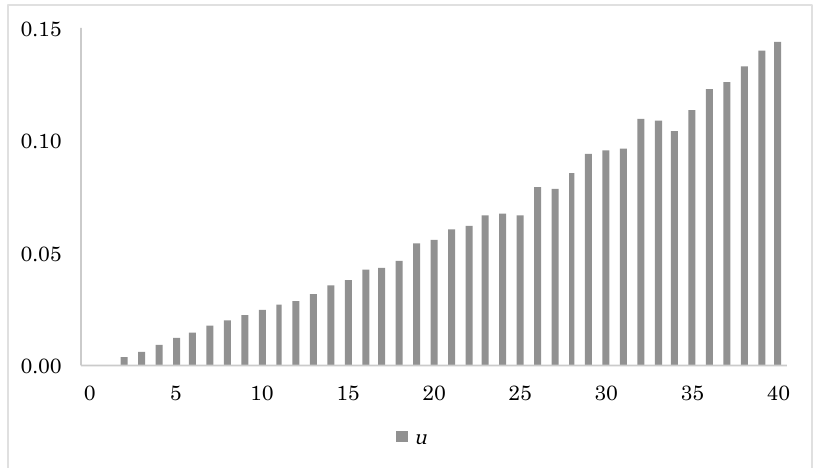
Figure 10. Approximated expected guarantee upgrade u as a function of